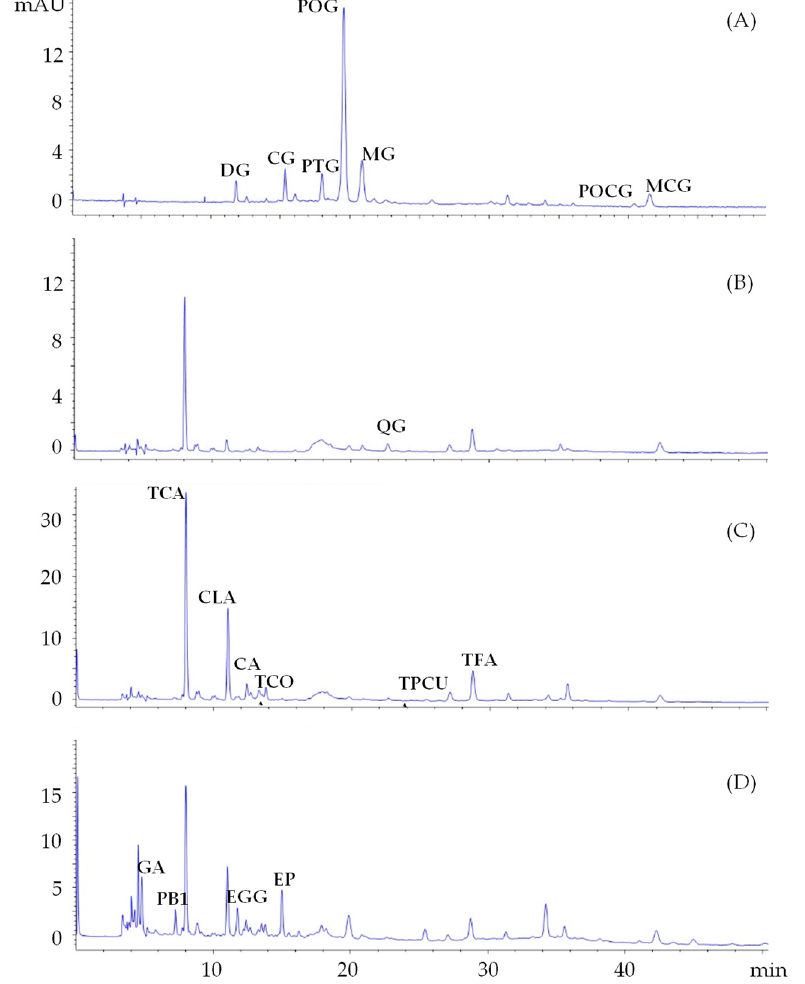
Figure 1. HPLC chromatograms registered at (A) 520 nm (DG = delphinidin-3 O -glucoside; CG = cyanidin-3 O -glucoside; PTG = petunidin-3 O -glucoside; POG = peonidin-3 O -glucoside; MG = malvidin-3 O -glucoside; POCG = peonidin-3 O -t-coumaroylglucoside; MCG = malvidin-3 O -t-coumaroylglucoside), (B) 360 nm (QG = quercetin-3 O -glucoside), (C) 320 nm (TCA = trans -caftaric acid; CLA = chlorogenic acid; CA = caffeic acid; TCOA = trans -coutaric acid; TPCUA = trans -p-coumaric acid; TFA = trans -ferulic acid), and (D) 280 nm (GA = gallic acid; PB1 = procyanidin B1; EG = ( ‒ )-epigallocatechin; PB2 = procyanidin B2; ( ‒ )-EGG = epigallocatechin gallate; EP = ( ‒ )-epicatechin). Table 2. Content (expressed in mg g − 1 ) of the identified polyphenols into the wine lees extracts.